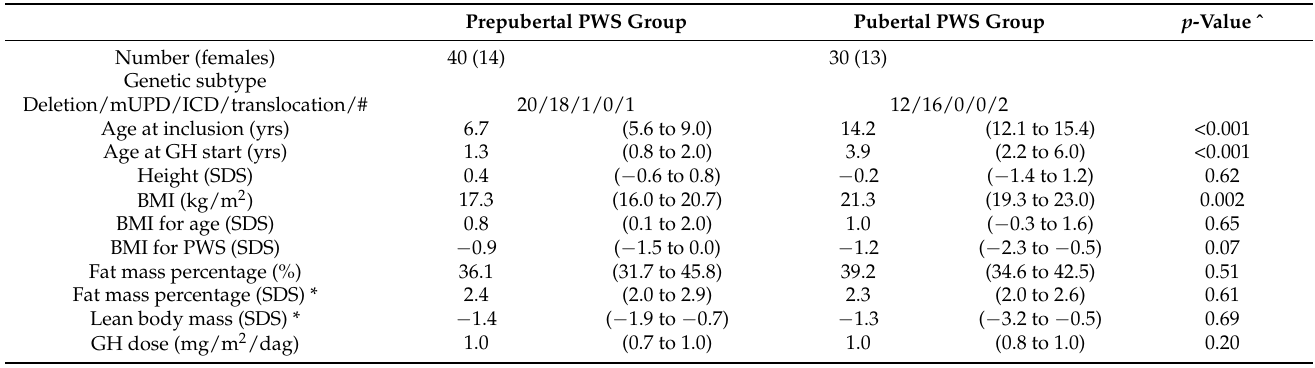
Table 1. Clinical Characteristics of PWS groups.